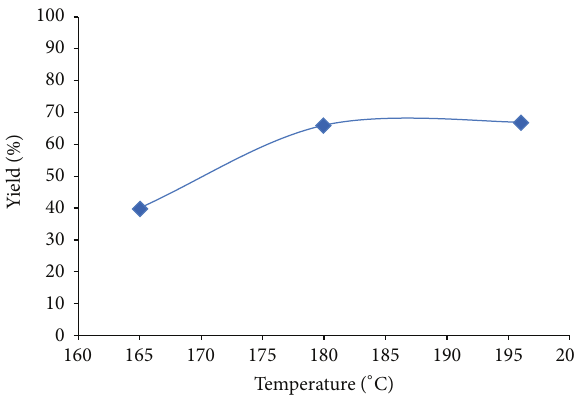
Figure 8: The effect of reaction temperature on BHET yield (EG: PET molar ratio 7.6: 1, PET:Zn(Ac) 2 molar ratio 100: 1) [8].